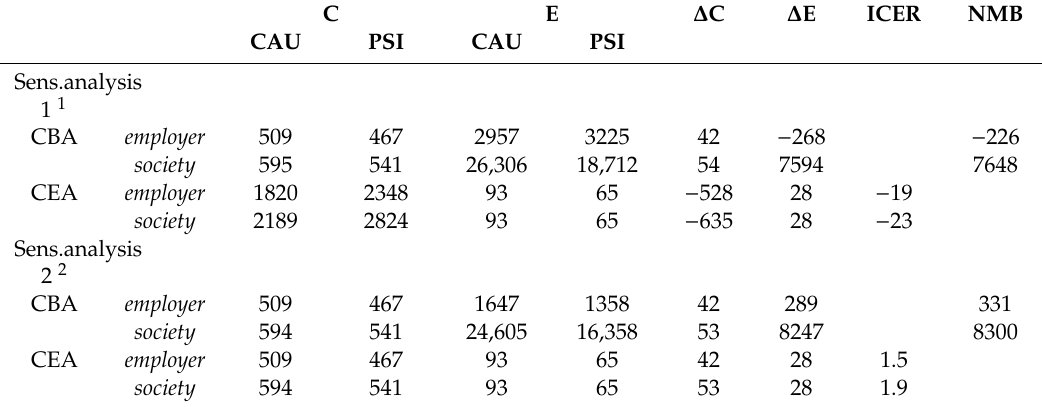
Table 6. Incremental Cost, E ff ect and ICERs for the Sensitivity Analysis, from both an Employer and a Societal